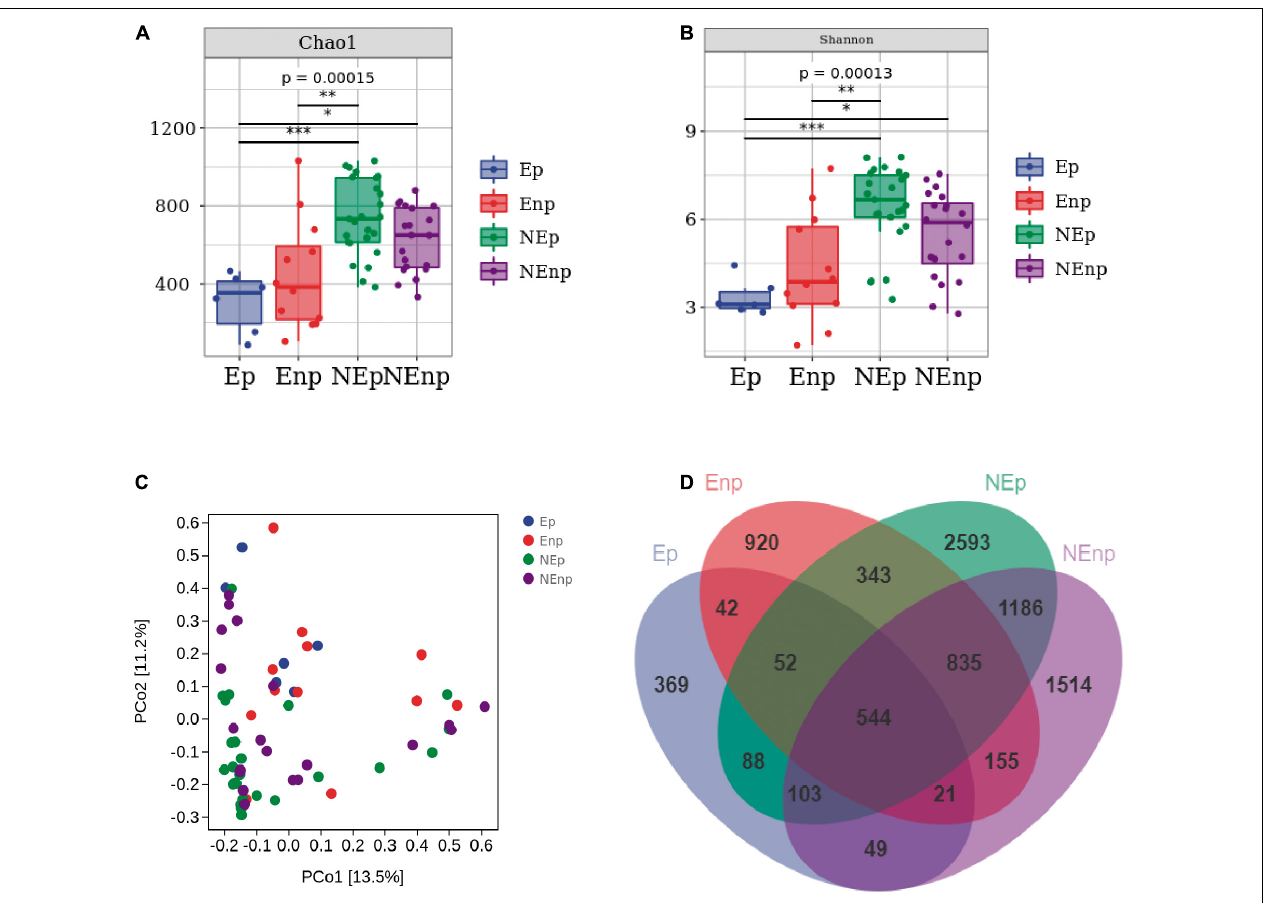
FIGURE 3 | Evaluation of the uterine microbiota on alpha-diversity (within samples), beta-diversity (between samples), and Venn diagram. (A) Chao1 index. (B) Shannon index. (C) Principal coordinates analysis (PCoA). (D) ASV/OTU Venn diagram. Values are expressed as mean ± SD. * p < 0.05, ** p < 0.001, *** p <